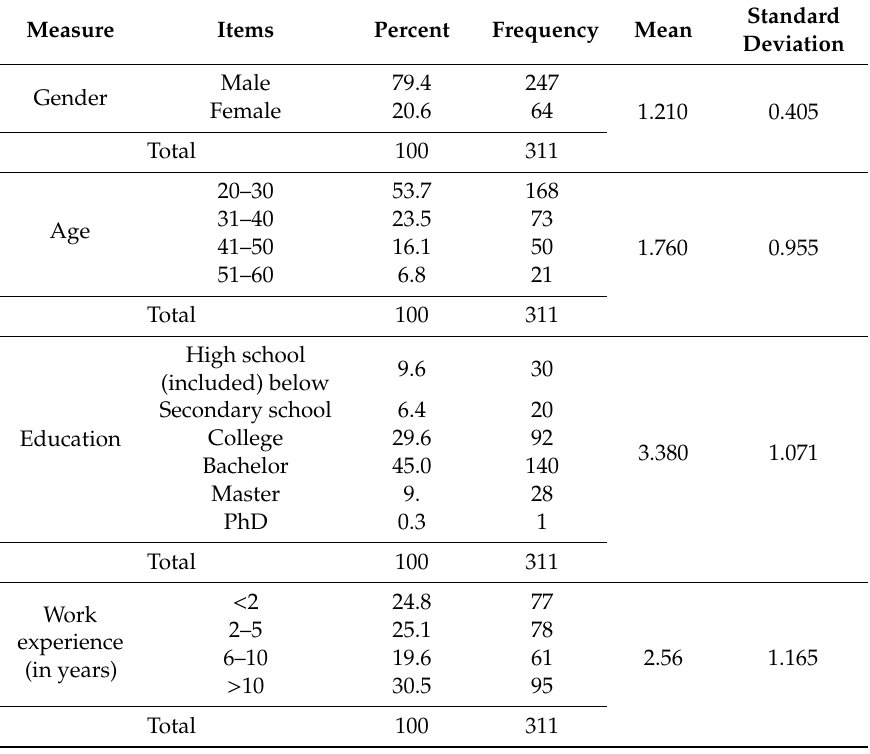
Table A2. Demographic characteristics of